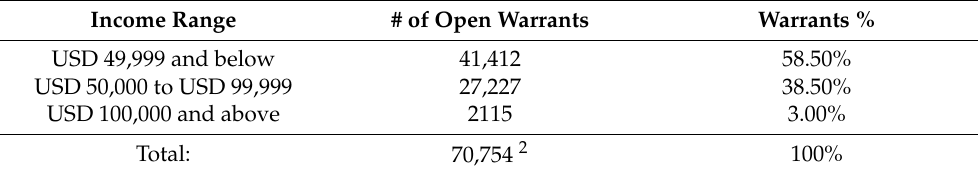
Table 4. Distribution of Income of Based on Defendant’s Address 1